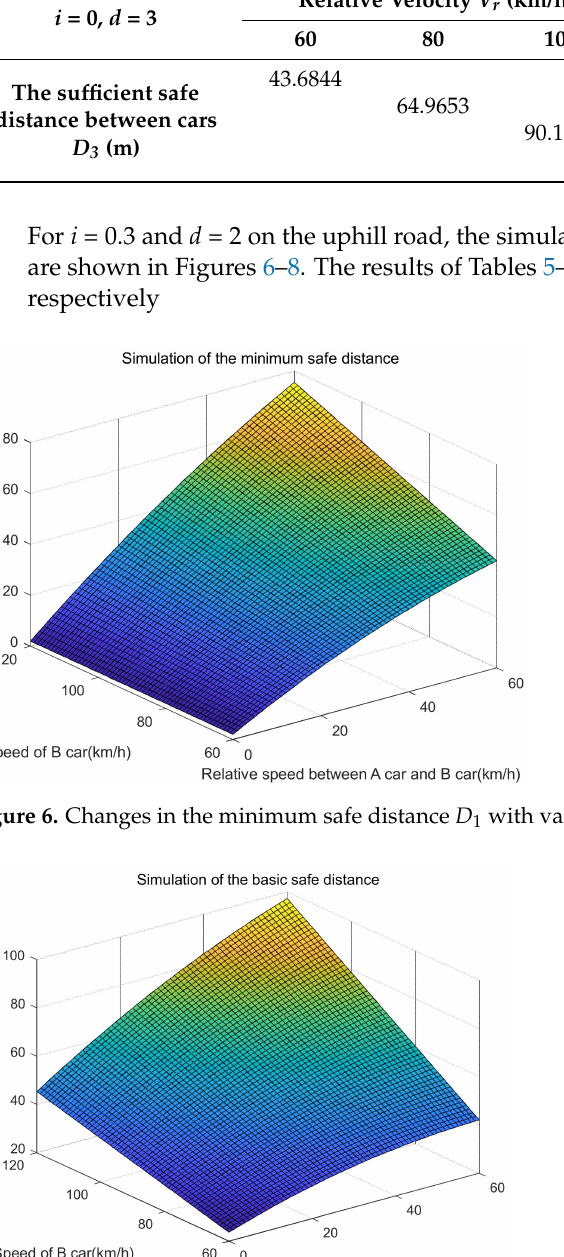
Table 4. The sufficient safe distance D 3 based on V B between 60 and 120 km/h when i = 0 and d = 3. i = 0, d = 3